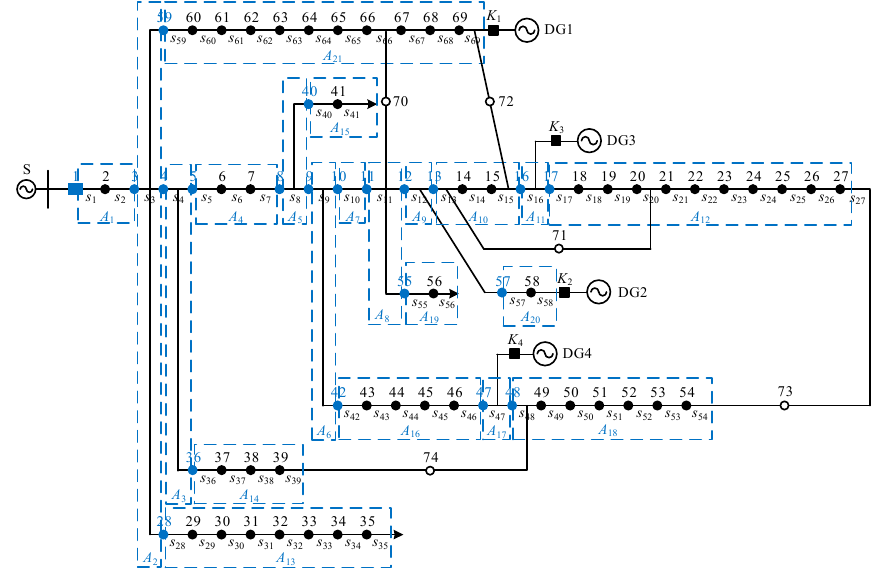
Figure 9. IEEE 69-node distribution network.